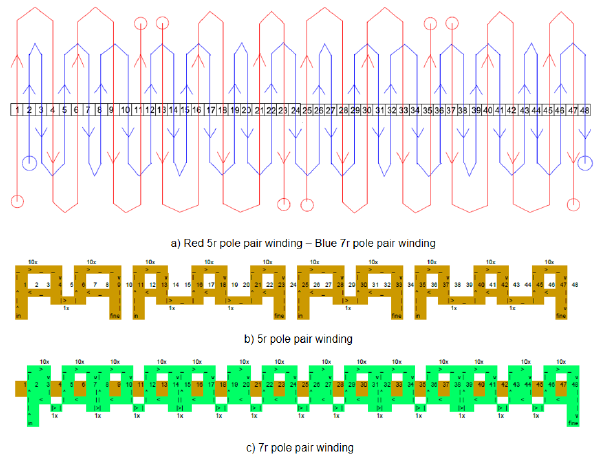
Figure 4. Rotor windings schematic